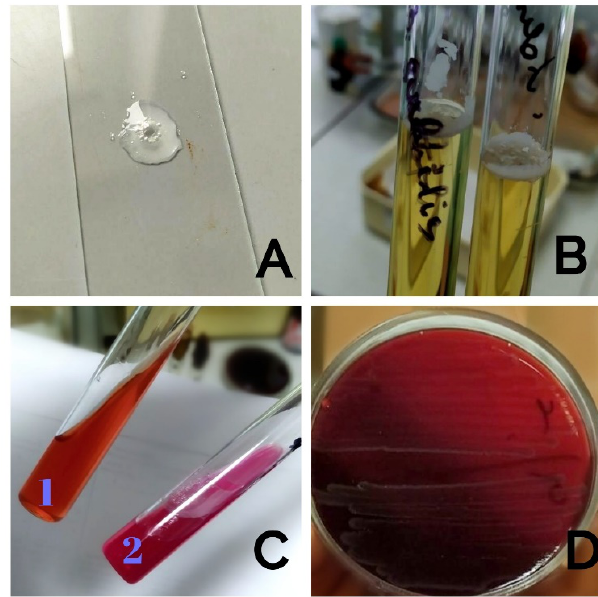
Fig. 4. Study of physiological properties and mobility of the isolated isolate of Bacillus subtilis . (A) catalase test, (B) mobility test, (C) discoloration of the carbohydrate substrate during fermentation of monosaccharides (1. control